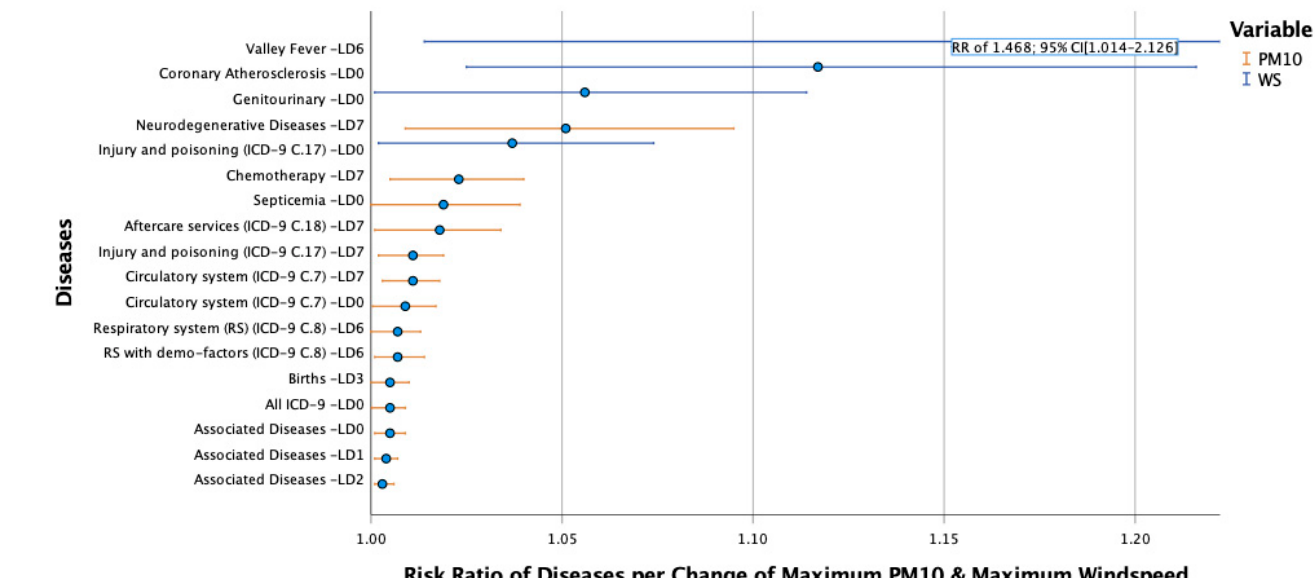
Figure 4. Risk ratios after dust exposures defined by daily 100 µ g/m 3 increase in maximum hourly PM 10 or daily 4.5 m/s increase in maximum wind speed with their respective lag days.